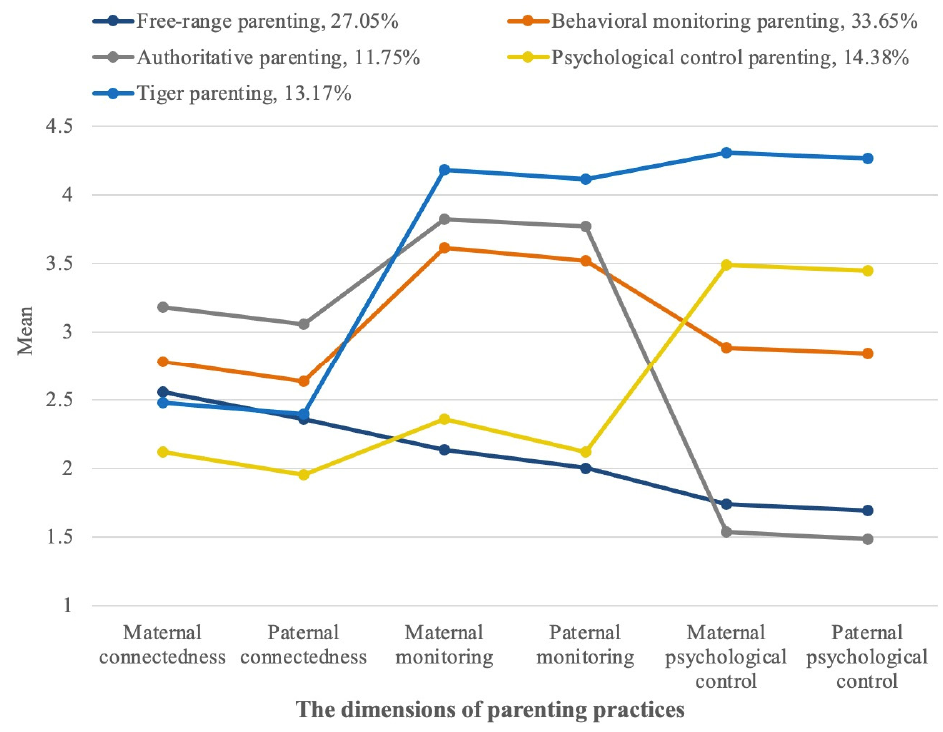
Figure 1. Five parenting practice profiles from the best-fitting five-class pattern.